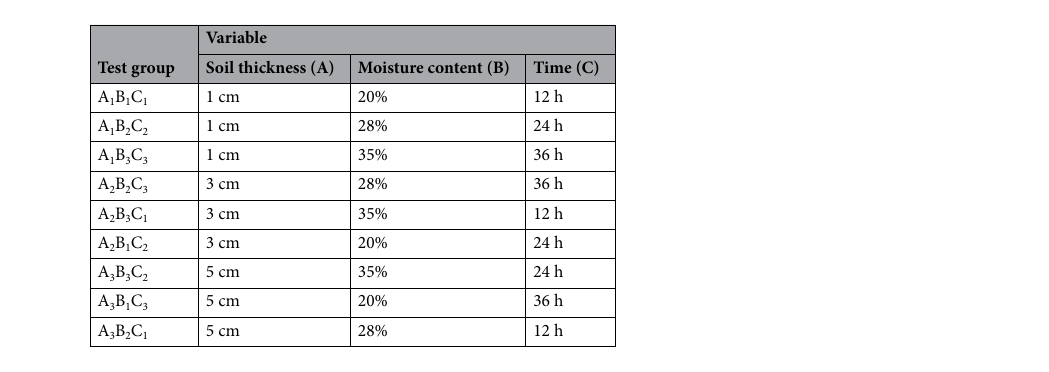
Table 2. Dry shrinkage orthogonal test